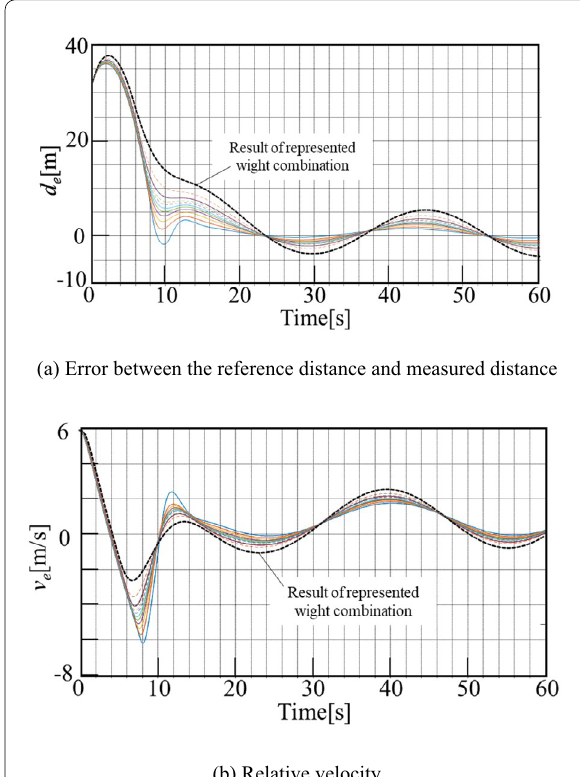
Fig. 8 Simulation results of tuning specialized in comfortability